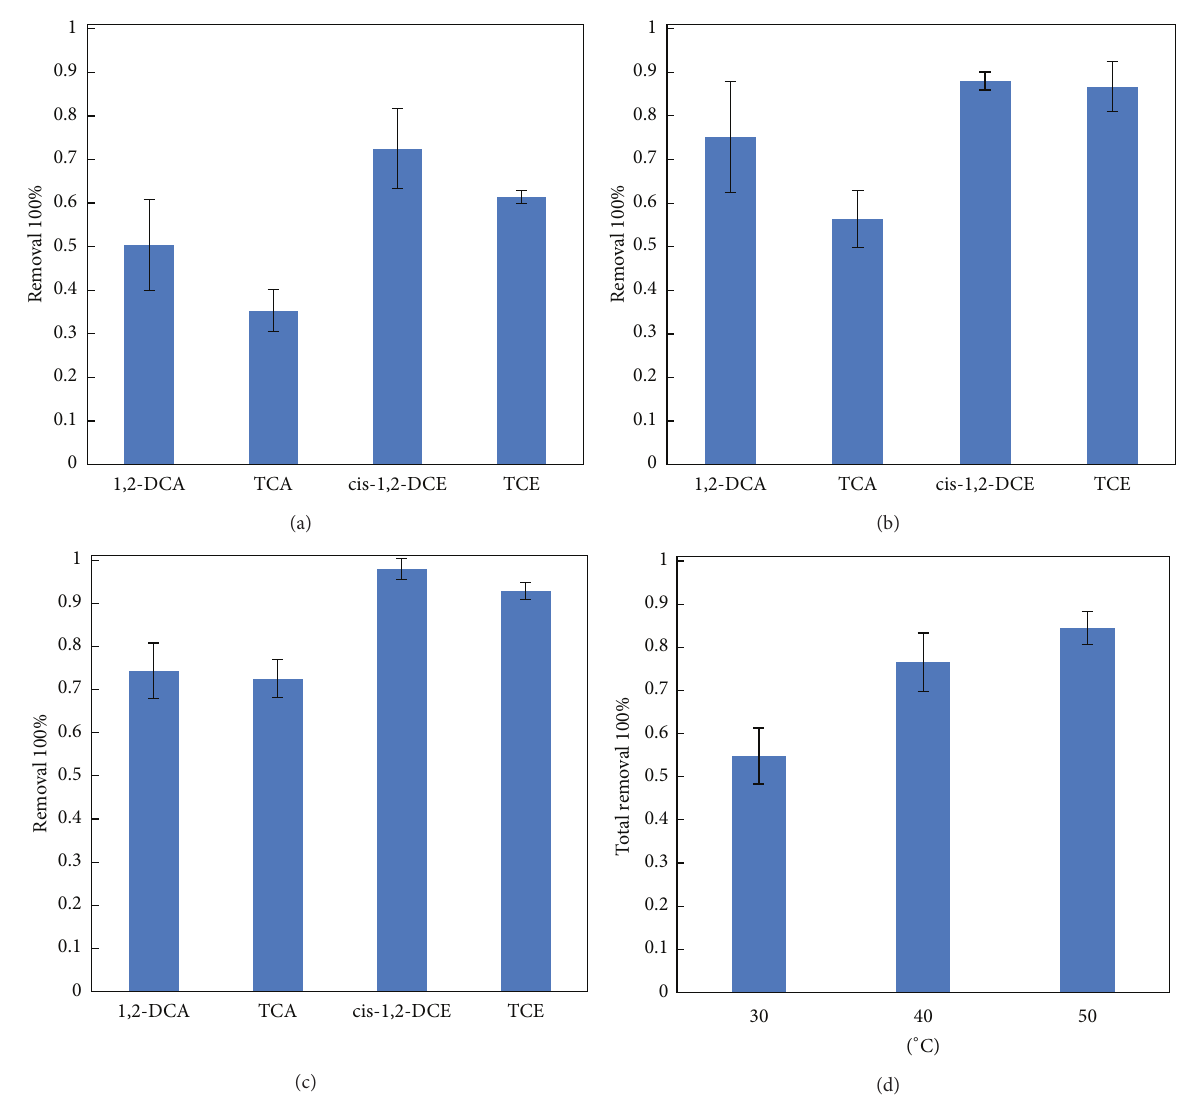
Figure 4: The depletion of chlorinated organic solvents by activated persulfate at different temperatures: (a) 30 ∘ C, (b) 40 ∘ C, and (c) 50 ∘ C after 72 h reaction